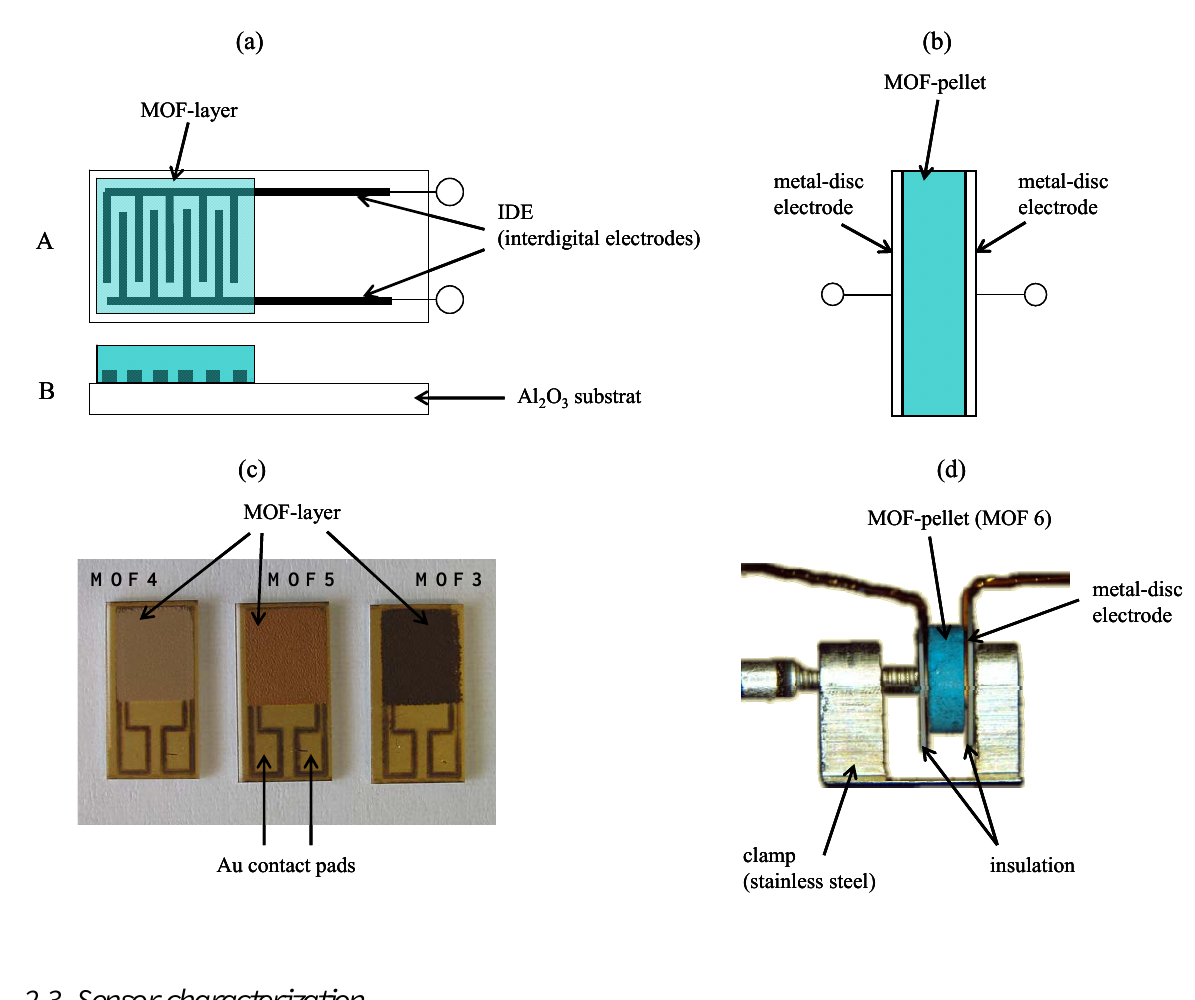
Figure 1. Sensor set-up. Left side: Planar sensor in thick-film technology, MOF paste screen-printed on laser-patterned interdigital electrodes (IDE), (a) schematic top view and cross section, (c) top view of real sensors with MOF materials (Fe-BTC ld , Fe-BTC fd ). Right side: Pellet-type MOF-sensor with metal-disc electrodes, (b) schematic view, (d) photography of a sensor, the two metal-disc electrodes were pressed to the sides of the pellet by an adjustable screw in a